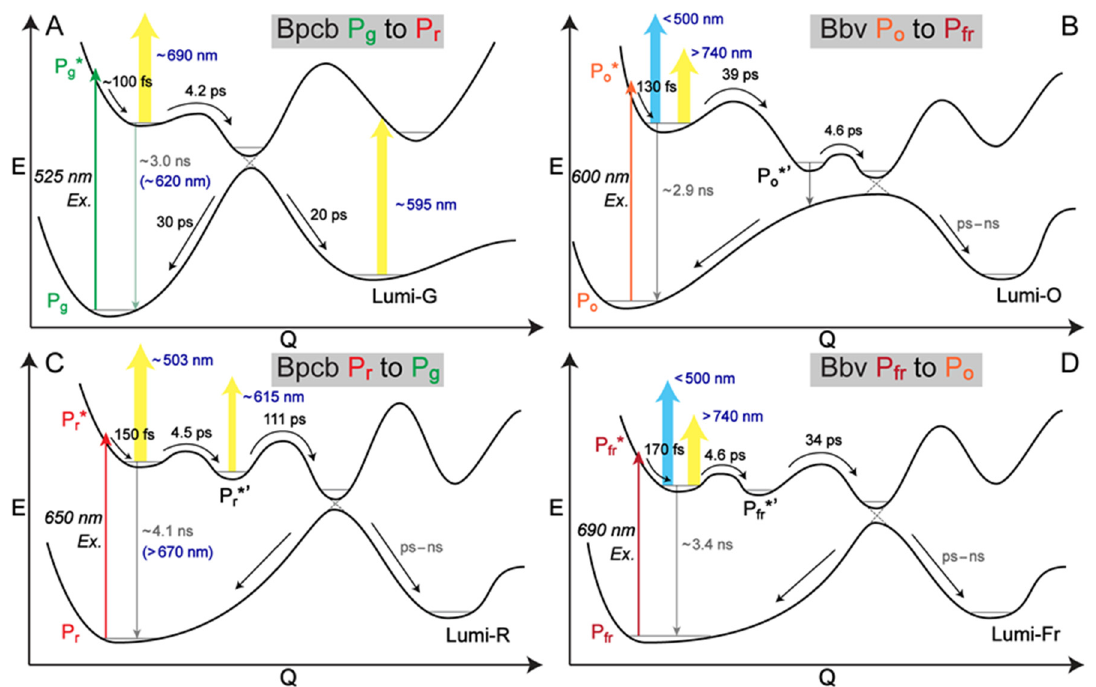
Figure 5. Representative potential energy surfaces of Bpcb ( A ) P g → P r , ( C ) P r → P g , and Bbv ( B ) P o → P fr , ( D ) P fr → P o photoconversion. The photoexcitation (Ex.), ESA, SE, GSB, and HGSA transitions are illustrated by the color-coded vertical arrows. The arrow lengths are not drawn to scale with the exact energy gaps. Reaction scheme is denoted by curved arrows with characteristic time constants retrieved from global analysis of the corresponding TA spectra in Figures 2 and 3. A minor fluorescence component is shown by a dim downward arrow. The ps-ns time scales for Lumi state formation in panels ( B – D ) indicate a long-lived state beyond our current detection time window. The horizontal axis “Q” represents the dominant cofactor ring-twisting motions that could change as time progresses after photoexcitation, while the protein environment continuously contributes to the cofactor nuclear motions.